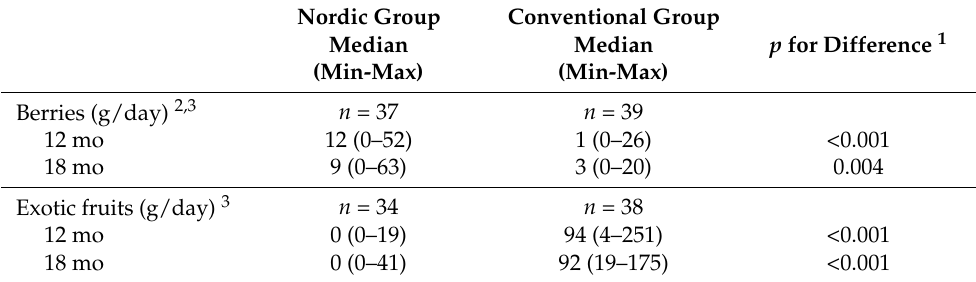
Table 5. Daily intake of berries and exotic fruits at the 12 and 18 mo 5-day dietary registrations.